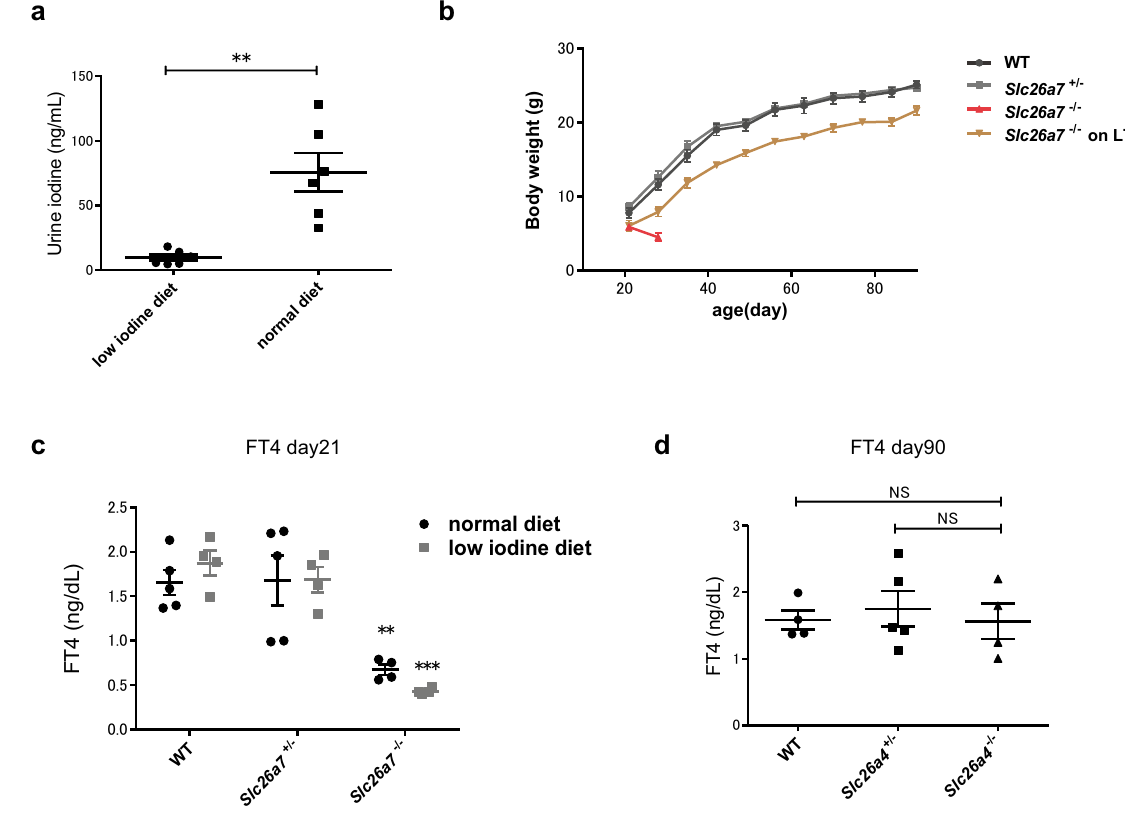
Figure 3. Phenotypes of Slc26a7 −/− and Slc26a4 −/− mice on a low iodine diet. ( a ) Urine iodine levels of female Slc26a7 +/− mice with normal and low iodine diets; n = 6 mice in each group. ** p < 0.01 determined by Student’s t test. ( b ) Growth curve of male wild type (WT), Slc26a7 +/− , Slc26a7 −/− , and Slc26a7 −/− mice receiving l-thyroxine (L-T4) replacement from day 21 with a low iodine diet. Note that Slc26a7 −/− mice without thyroid hormone replacement did not survive. ( c ) Serum free thyroxine (FT4) levels in male WT, Slc26a7 +/− , and Slc26a7 −/− mice with normal and low iodine diet at day 21; n = 4–5 mice of each genotype. Two-way analysis of variance (ANOVA) showed significant effects of genotype ( F (2, 20) = 29.92, p < 0.0001). ** p < 0.01, *** p < 0.001 determined by Tukey’s test compared with WT mice with same diet. ( d ) Serum FT4 levels in male WT, Slc26a4 +/− , and Slc26a4 −/− mice that were fed a low iodine diet, at day 90; n = 4–5 mice of each genotype. One- way ANOVA showed no significant differences among the three groups ( F (2, 10) = 0.19, p = 0.83). WT wild type, L-T4 l-thyroxine, FT4 free